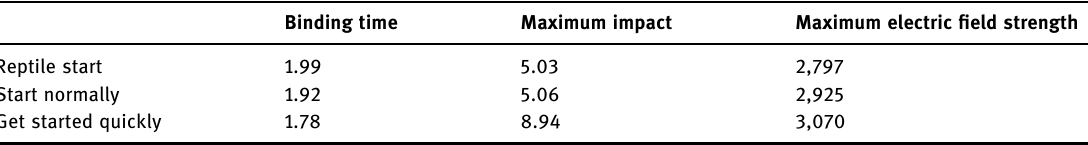
Table 2: The degree of impact is in the comfort